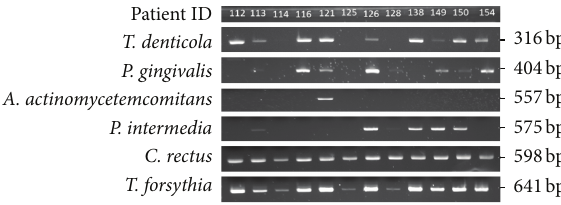
Figure 1: Representative results of electrophoresis of PCR products from dental plaque samples, patients ID 112 to